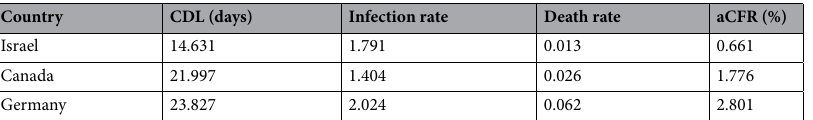
Table 2. Weighted averages of CDLs, infection rates, death rates, and aCFRs calculated from peak fits and SIRD model parameters in Israel, Canada, and Germany during the second wave of the COVID-19 pandemic.